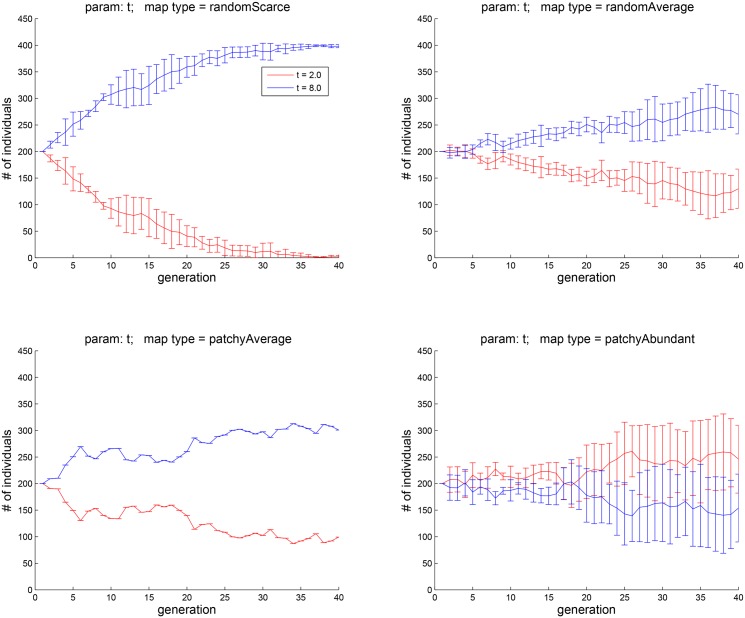
Experiment 4A: the influence of memory duration.The four plots corresponds to the four map types shown in Fig 2. When resources are scarce, agents with longer memory of past hedonic states tend to do better. When resources are abundant, this effect disappears.